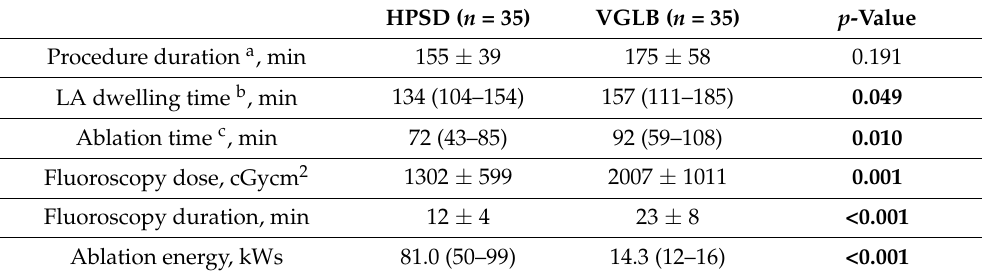
Table 3. Procedure data.